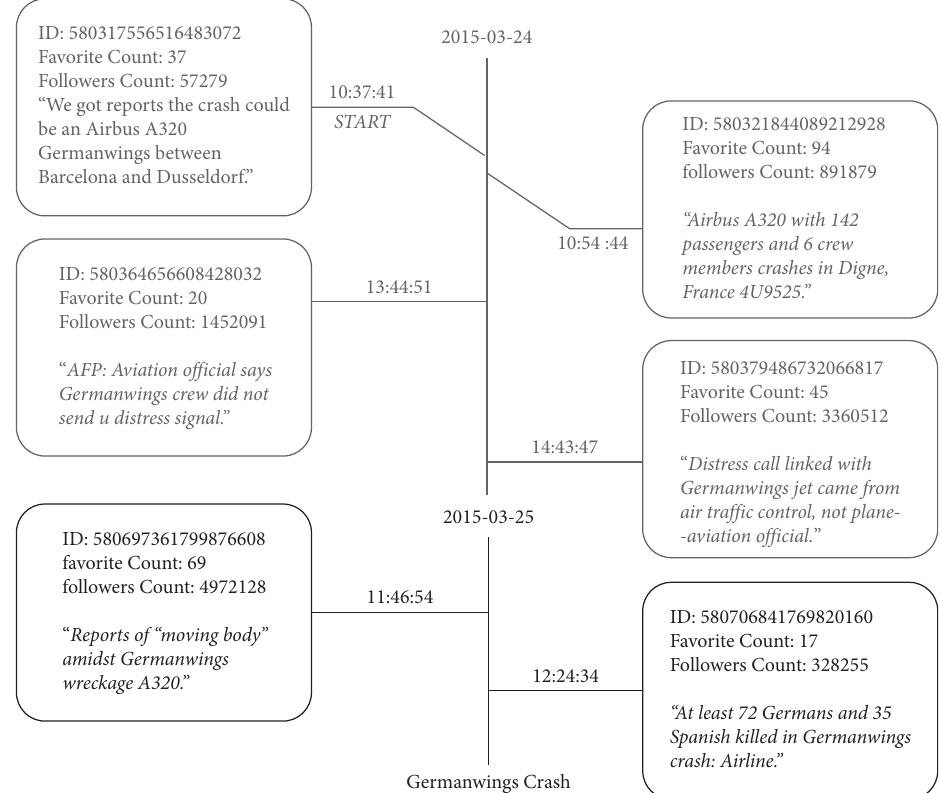
Figure 1: Rumors spread about the schematic “German Wings Crash” events